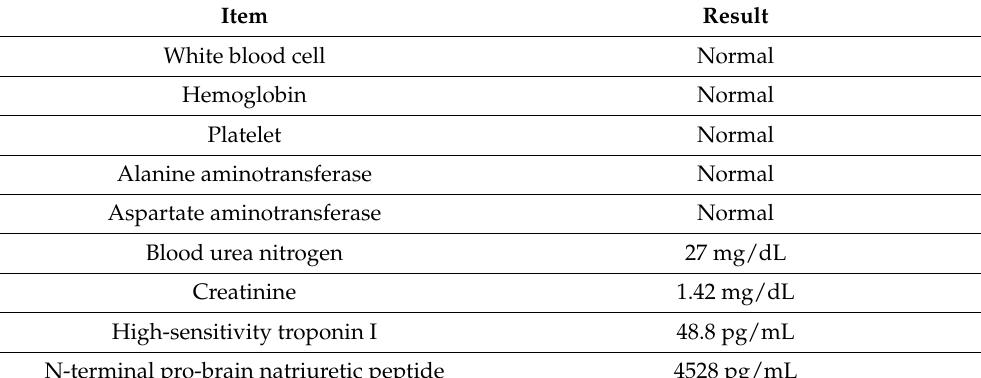
Table 1. Laboratory data.